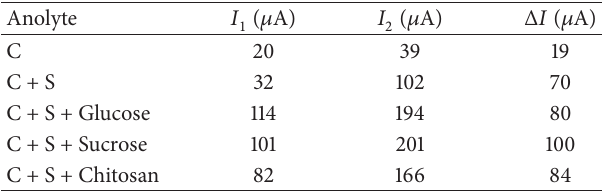
Table 1: Current of the biosolar cell with spirulina and carbohy-